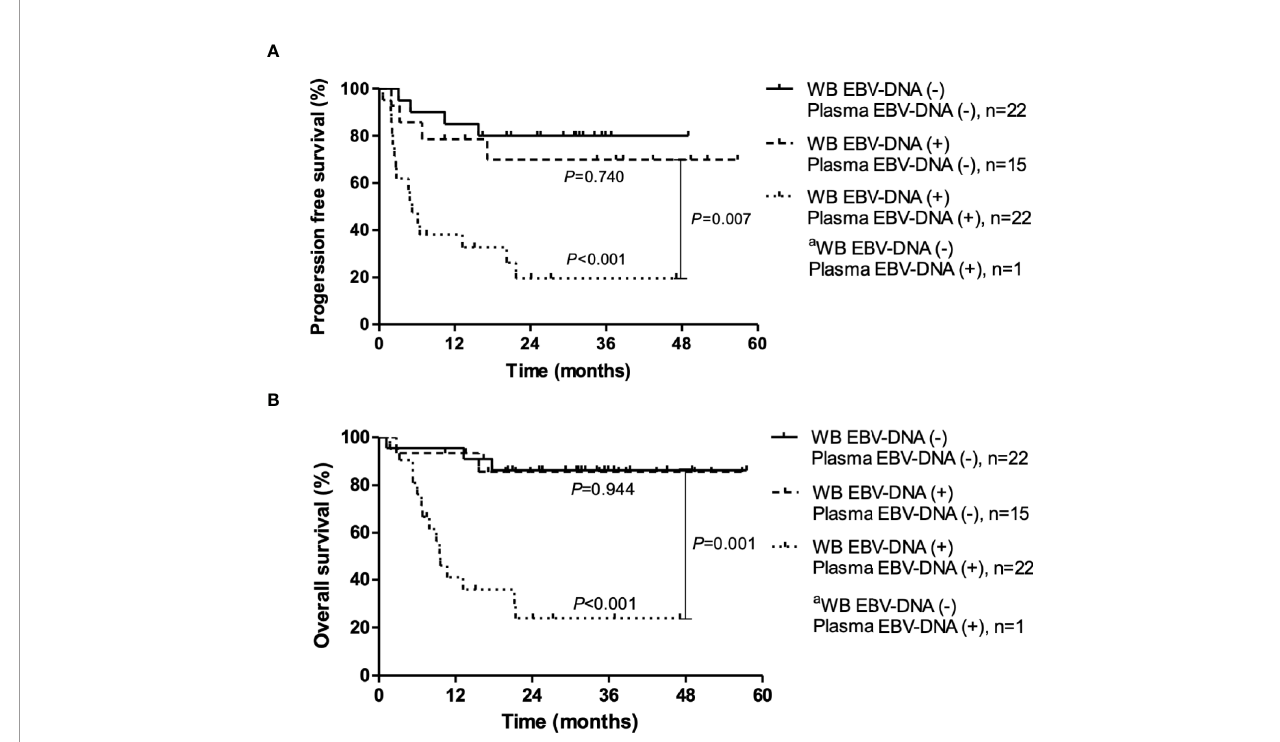
FIGURE 3 | Progression-free survival and overall survival according to pre-treatment Epstein-Barr virus (EBV) status in whole blood (WB) and plasma. (A) Progression-free survival. (B) Overall survival. P-values were calculated for log-rank comparison of the curves. a Because only one patient was WB EBV-DNA ( − ) and plasma EBV-DNA (+), the survival curve of this patient is not